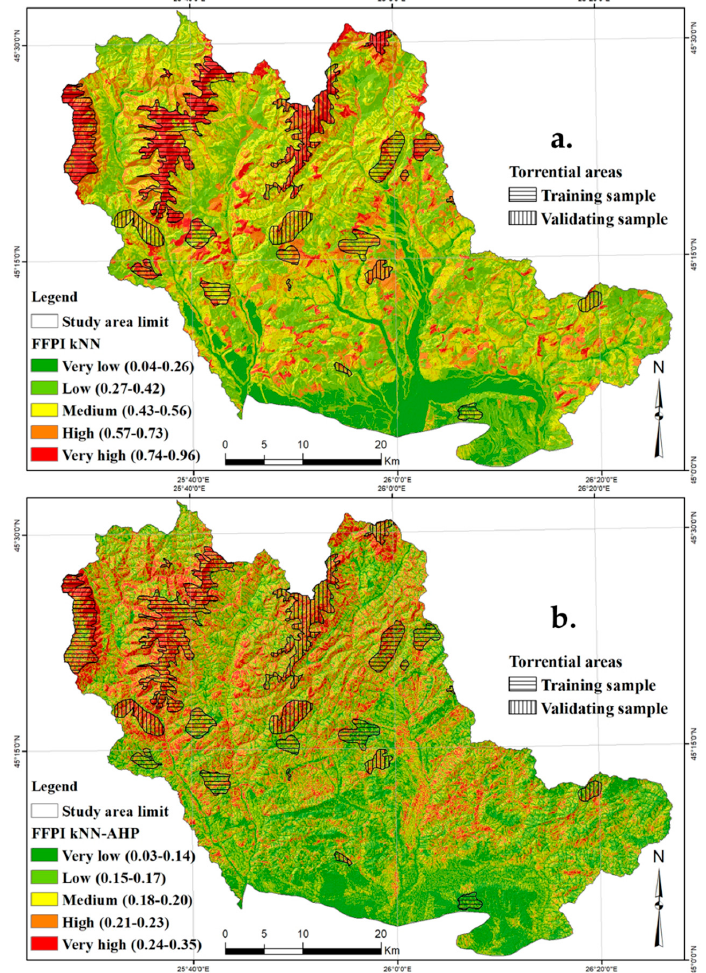
Figure 9. Spatial distribution of Flash-Flood Potential Index (FFPI) values: ( a ) Flash-Flood Potential Index—k-Nearest Neighbor (FFPI kNN ); ( b ) Flash-Flood Potential Index—k-Nearest Neighbor–Analytical Hierarchy Process (FFPI kNN–AHP ).